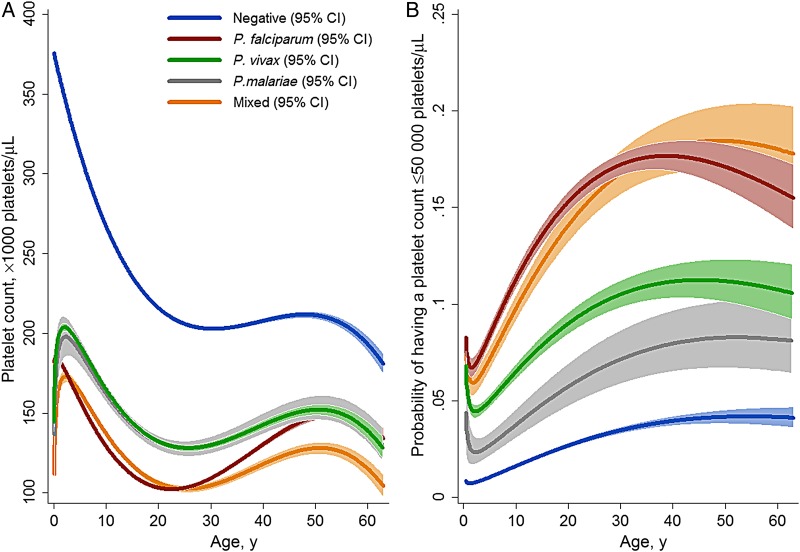
Estimated mean platelet count among hospital attendees (A) and estimated probability of severe thrombocytopenia (platelet concentration, <50 000 platelets/µL; B), by Plasmodium species. Figures were generated by multiple fractional polynomial regression analyses with the following covariables: Plasmodium species, by age, sex, ethnic group, and year. Bands represent 95% CIs. Abbreviation: CI, confidence interval.